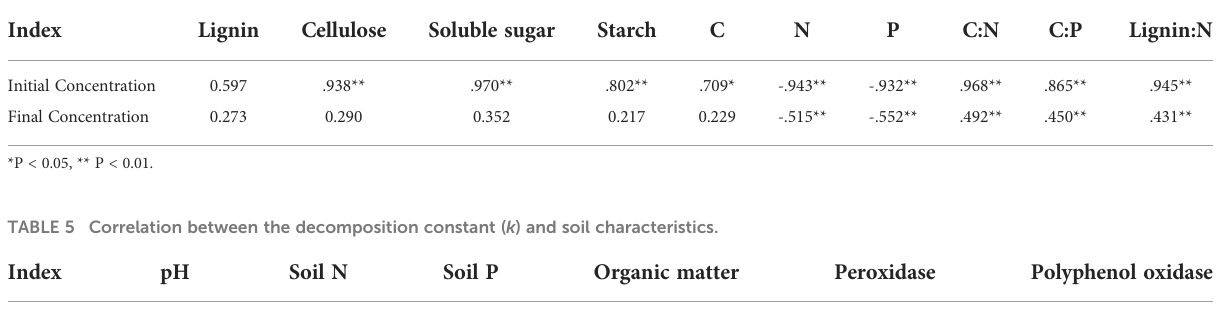
TABLE 4 Correlation between the decomposition constant ( k ) and nutrient concentration of fi ne roots.